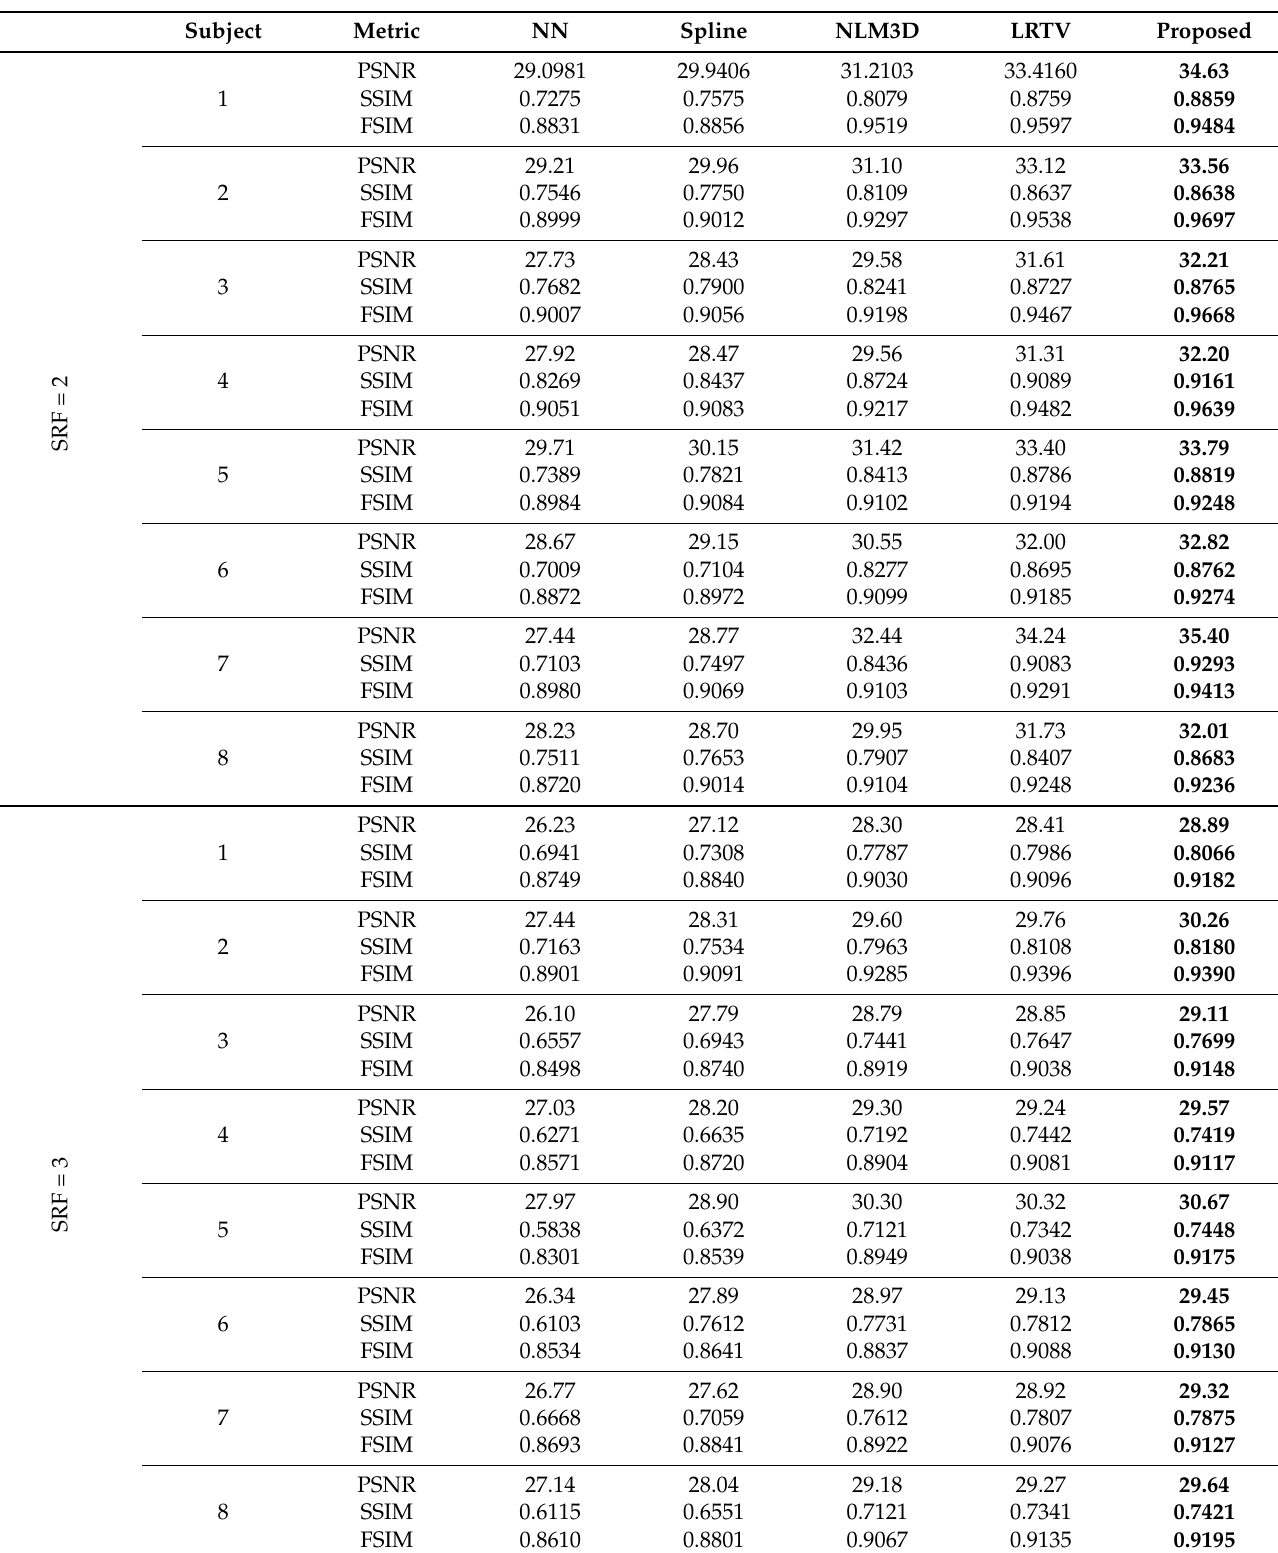
Table 2. PSNR, SSIM, and FSIM values obtained using different algorithms for super resolution of real MR images in all three directions by factors 2 and 3.